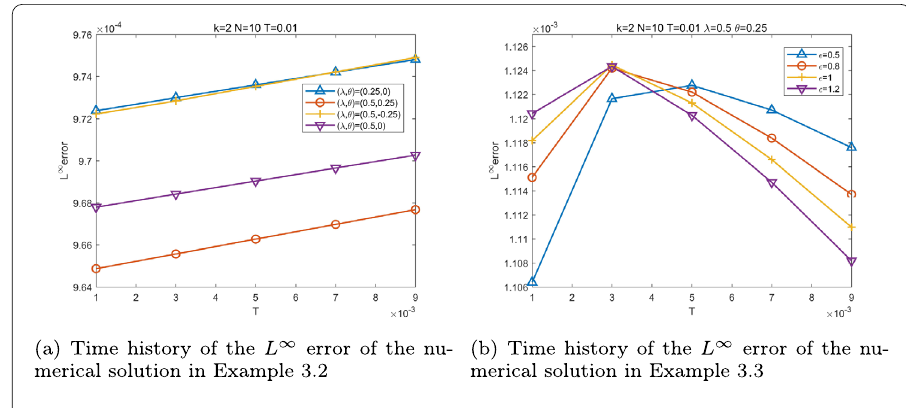
Figure 1 Time history of the L ∞ error of the numerical solution